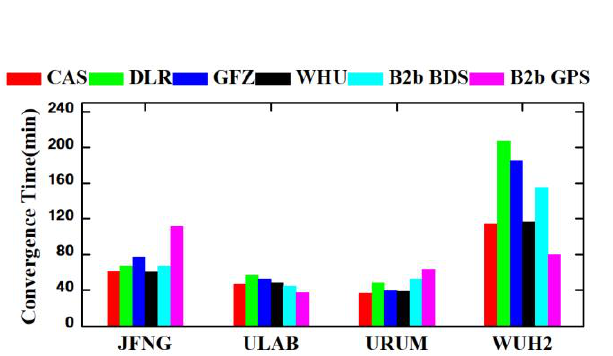
Figure 11. Convergence time of single-frequency PPP using different SSR products.